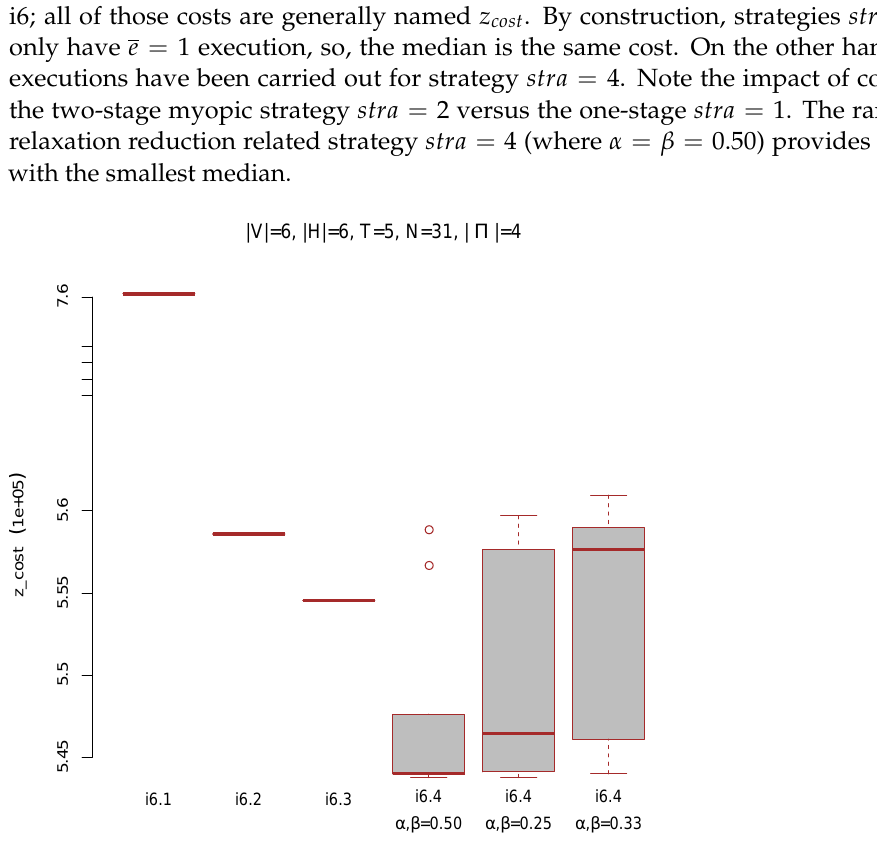
Figure 5. Instance i6. SFR3 strategies comparison. Cost distribution and median in e